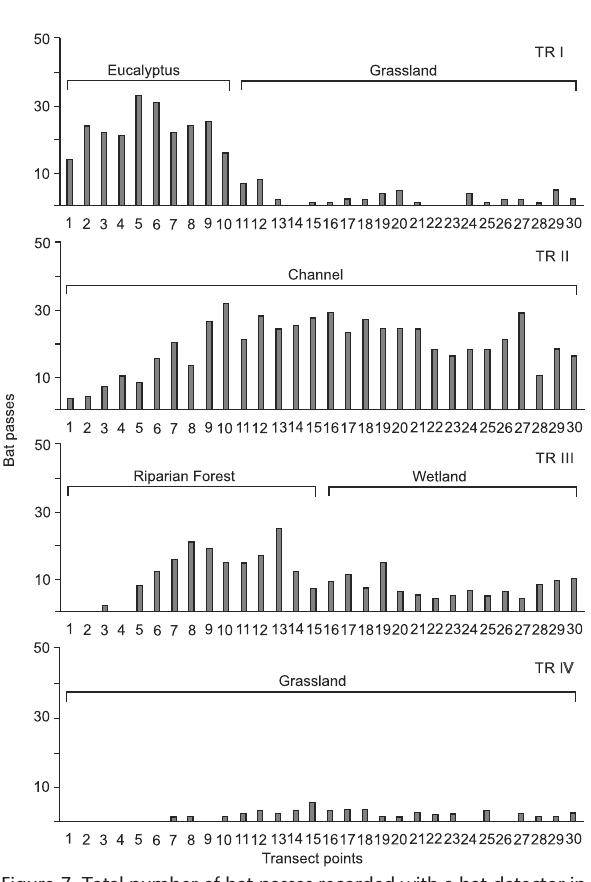
Figure 7. Total number of bat passes recorded with a bat detector in each fixed point on 1,500-m transects monitored for bat activity, from April 2009 to March 2010, in the grasslands of southernmost Brazil.